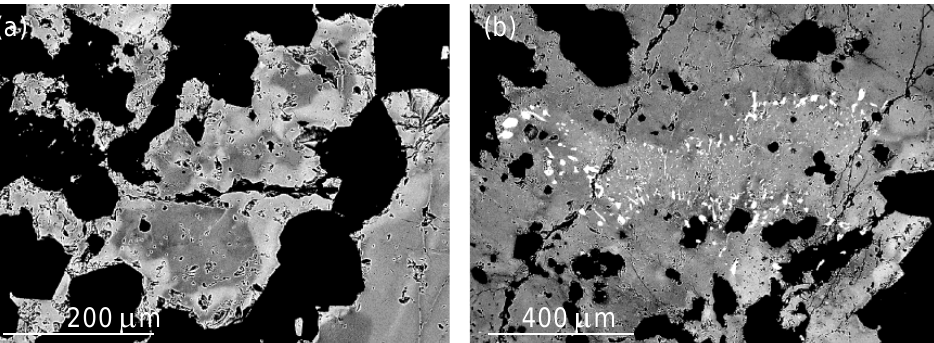
Figure 18. Ternary plot Fe – Hg – Zn ( apfu ) for members of the tetrahedrite group. Ag ( apfu ) 0.00